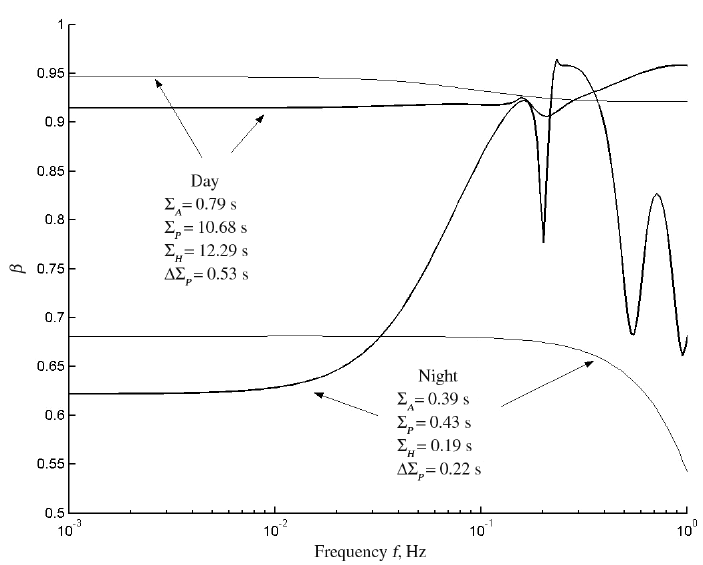
Fig. 2. Dependence of the relative magnetic field β at the ground on frequency for night and day hours. Thin lines show the results of calculations in the thin film ionospheric model, bold lines correspond to full-wave cal- culations in the IRI-90 model. k x = 0.01 km − 1 and other parameters are shown on the picture.